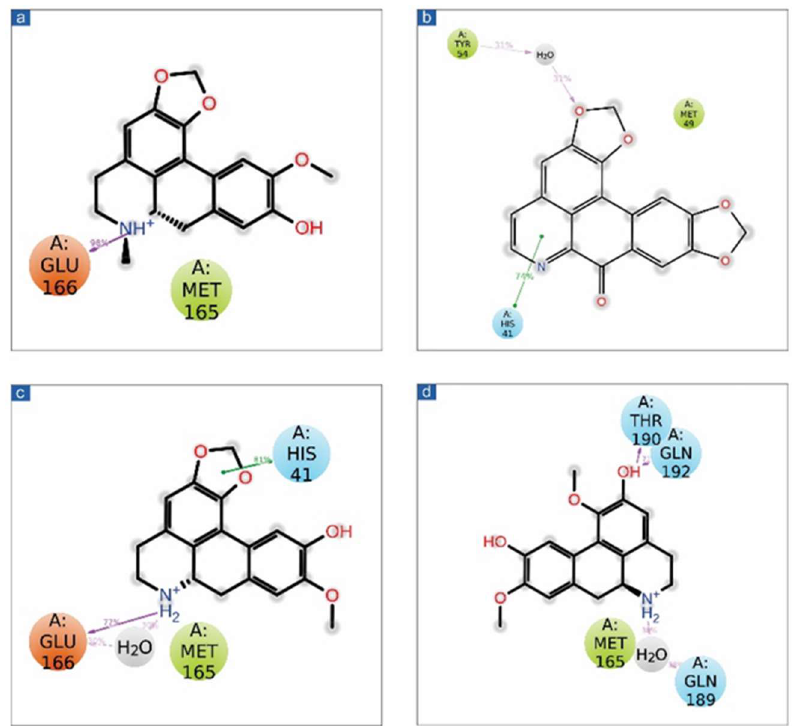
Figure 5 . Schematic representation for docked protein-ligand complexes, viz. ( a ) Cassameridine, ( b ) Laetanine, ( c ) Litseferine, and ( d ) Cassythicine, interaction profile extracted at 30% of total 100 ns simulation interval.